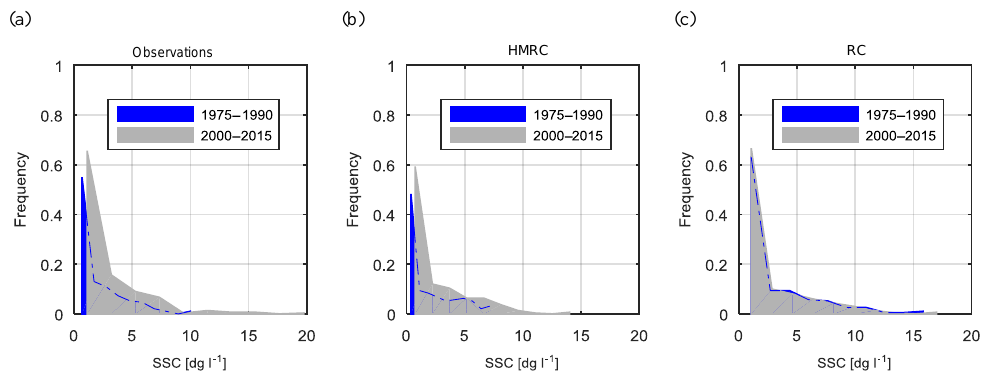
Figure 7. Empirical probability density functions of mean monthly SSC computed on twice-a-week samples: (a) observed, (b) simulated with HMRC, and (c) simulated with traditional RC for two 15-year periods 1975–1990 (blue) and 2000–2015 (grey).